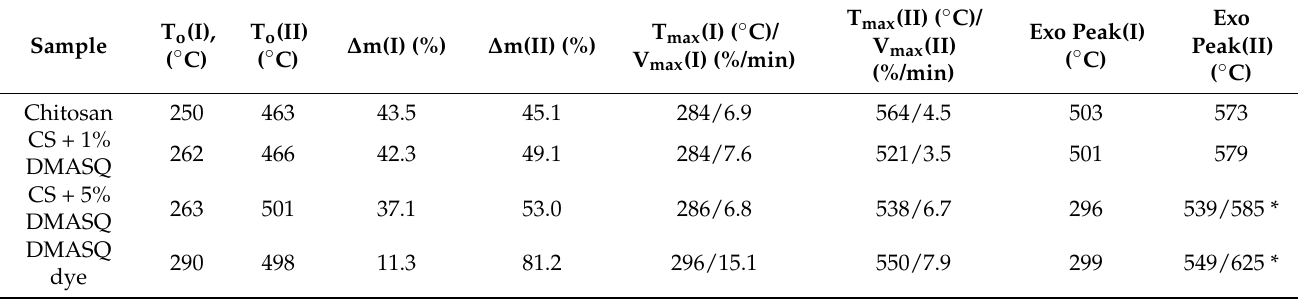
Table 1. The main parameters obtained from TG, DTG, and DTA curves of chitosan doped with DMASQ, virgin chitosan, and DMSQ dye (T o —onset temperature, T max —the temperature at maximum process rate, V max , ∆ m—weight loss, and exo peak—position of an exothermic peak at DTA; the Roman numerals I and II denote the first and second stage of the